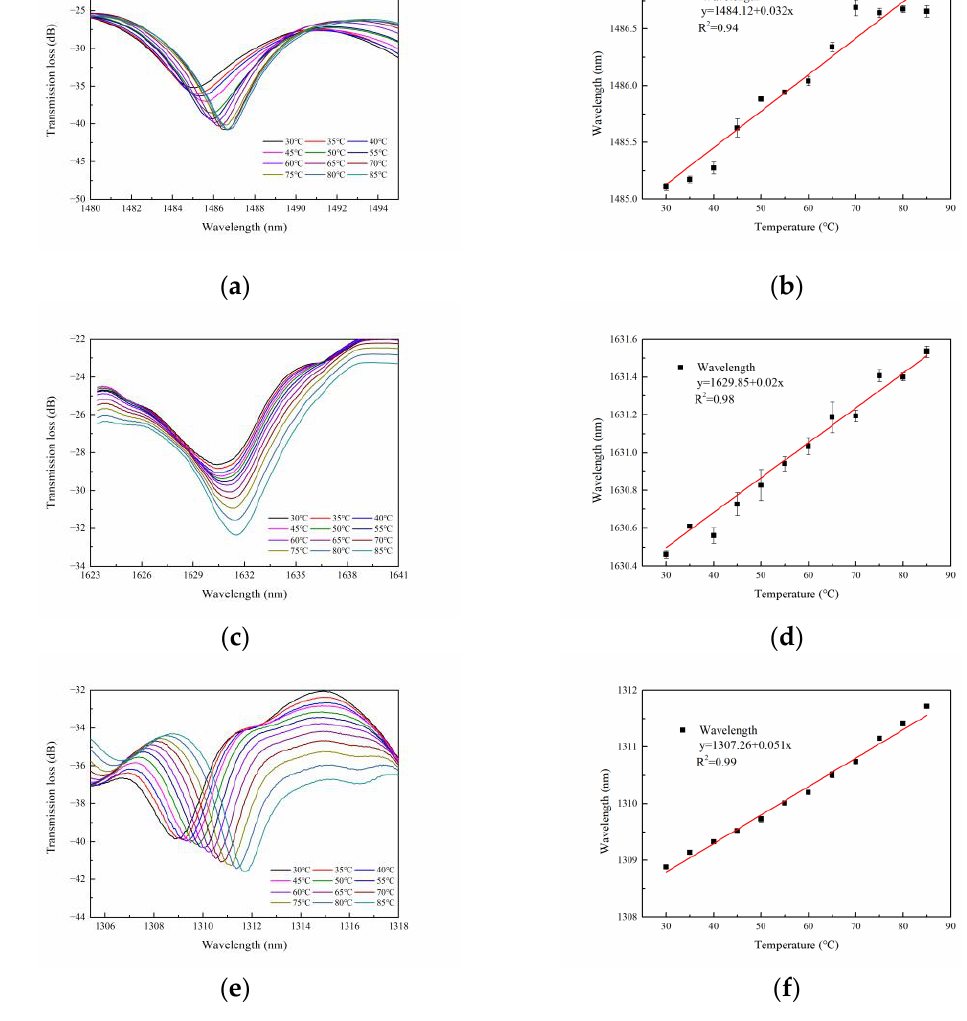
Figure 6. The temperature response of the sensor structure with pre-twisted angles of 180 degrees ( a , b ), 360 degrees ( c , d ), and 540 degrees ( e , f ). Table 1. Performance comparison of the reported torsion sensors. Table 1. Performance comparison of the reported torsion